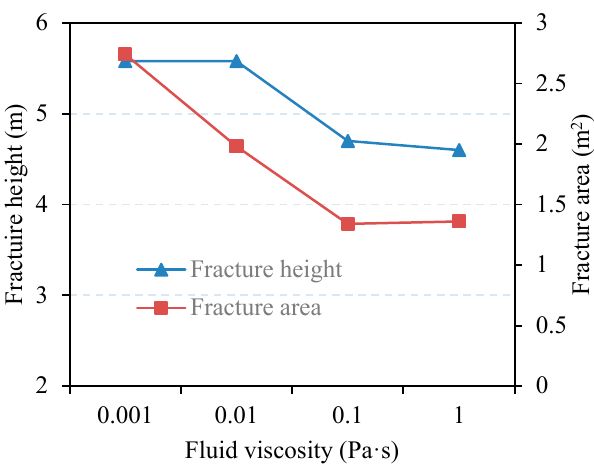
Figure 11. Variation in fracture height and fracture area versus fluid viscosity.